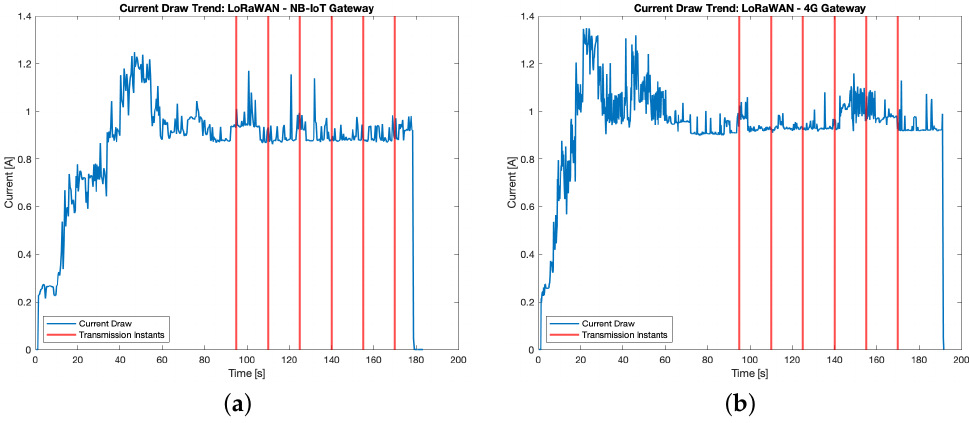
Figure 10. Gateways current consumption test results: ( a ) LoRaWAN-NB-IoT Gateway; ( b ) LoRaWAN- 4G